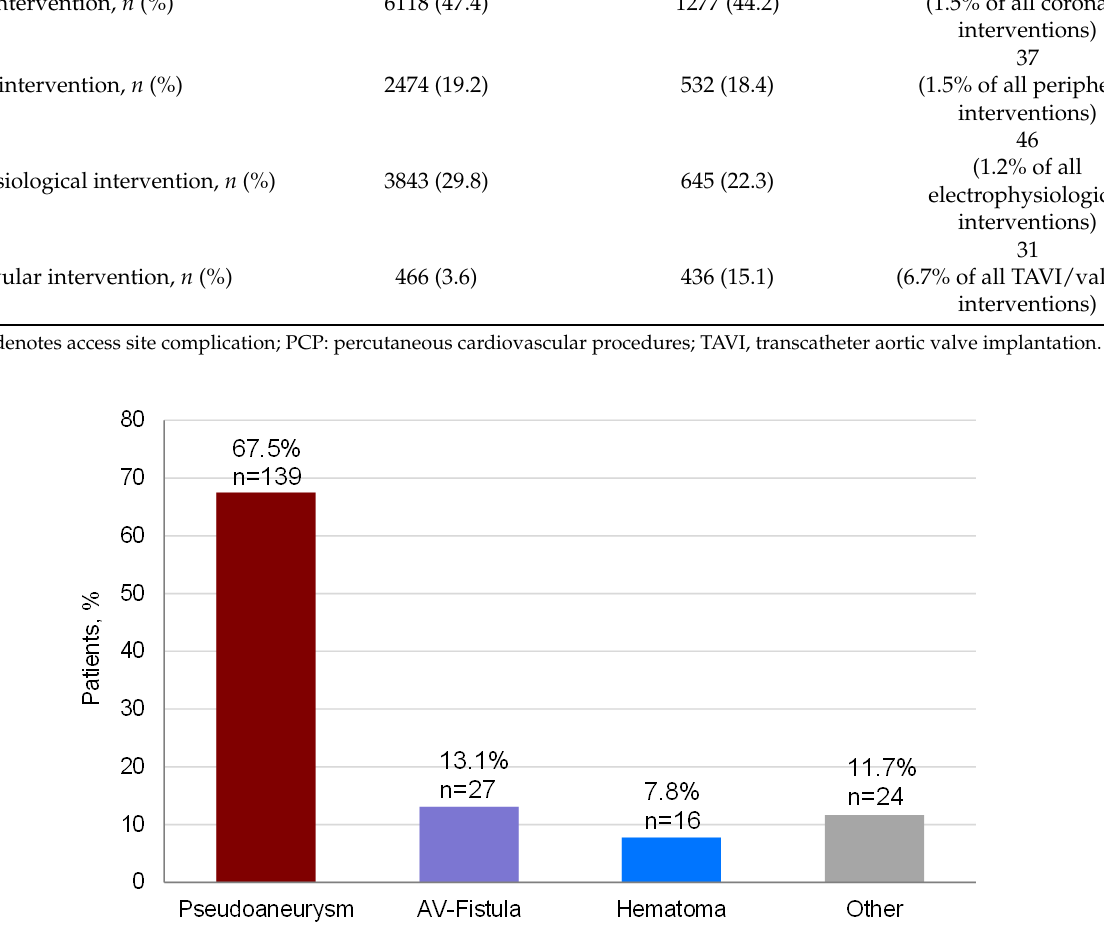
Figure 1. Type and frequency of access site complication. Pseudoaneurysm was the most frequent access site complication with 67.5% of all complications. Arteriovenous (AV) fistula, hematoma and other complications comprised between 7.8% and 13.1% of all access site complications. In patients with more than one access site complication, e.g., an AV fistula and a hematoma, only the most clinical relevant access site complication as the leading type was noted.